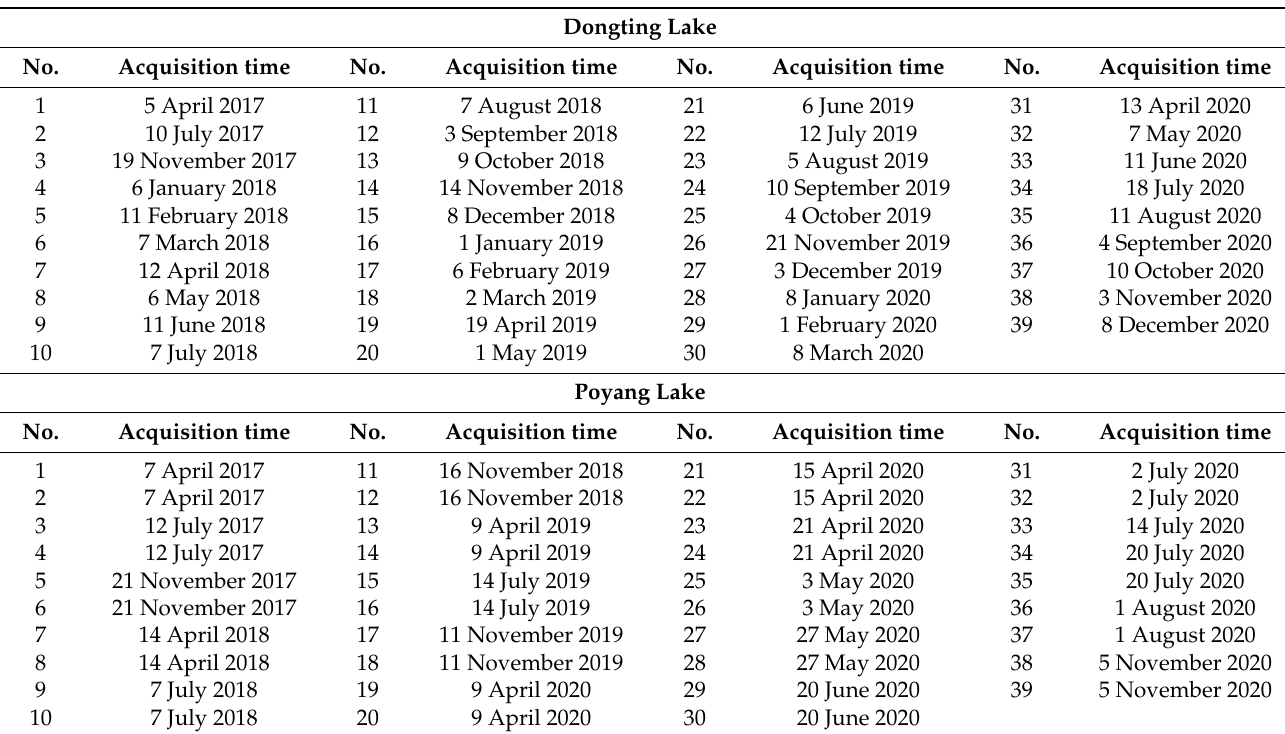
Table 1. Basic information for the Sentinel-1 data.